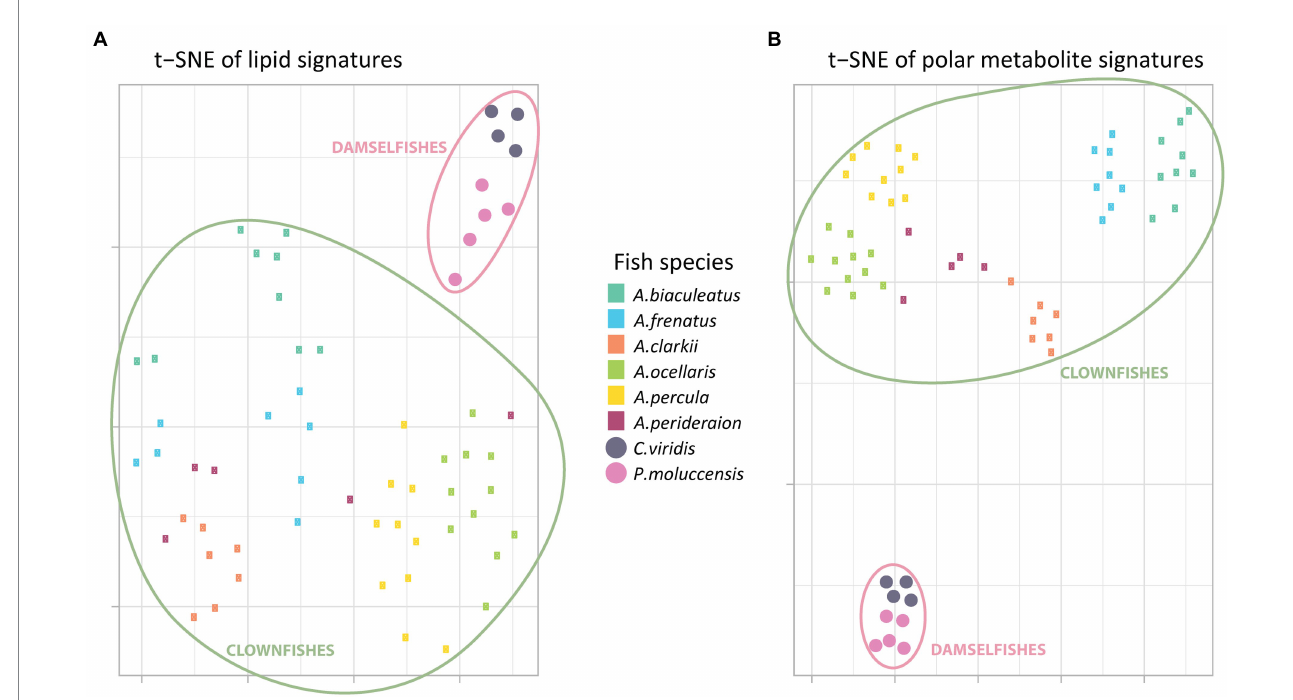
FIGURE 1 T-distributed stochastic neighbour embedding of the (A) global polar metabolome and (B) lipidome curated profiles (post data processing). Each little rectangle (clownfish) and circle (damselfish) represents one individual and each colour represents a fish species. The pink circles englobe the damselfishes and the green circles englobe the